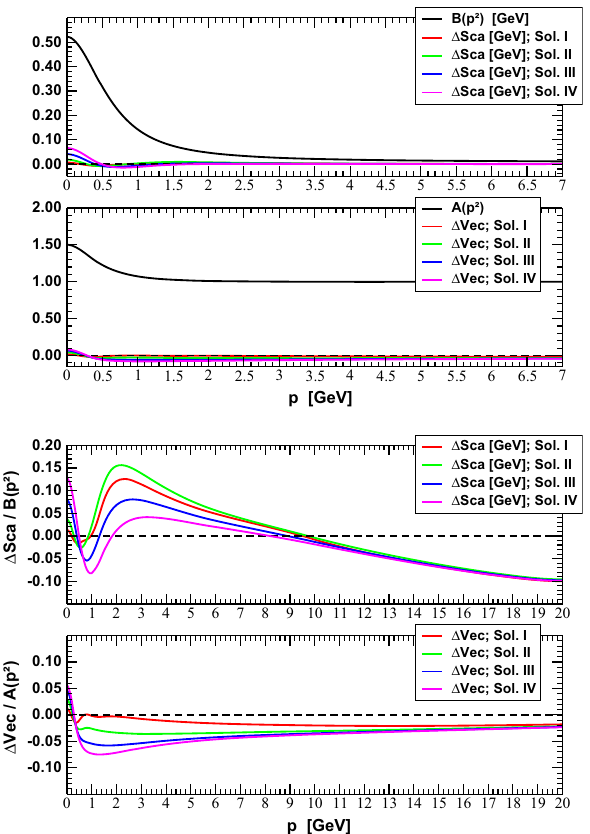
Fig. 19 The lhs of the Dyson–Schwinger equations, scalar component on top and vector component at bottom, together with Δ Sca and Δ Vec (top). The plots on the left are the relative error for the scalar equation (top) and vector equation (bottom)